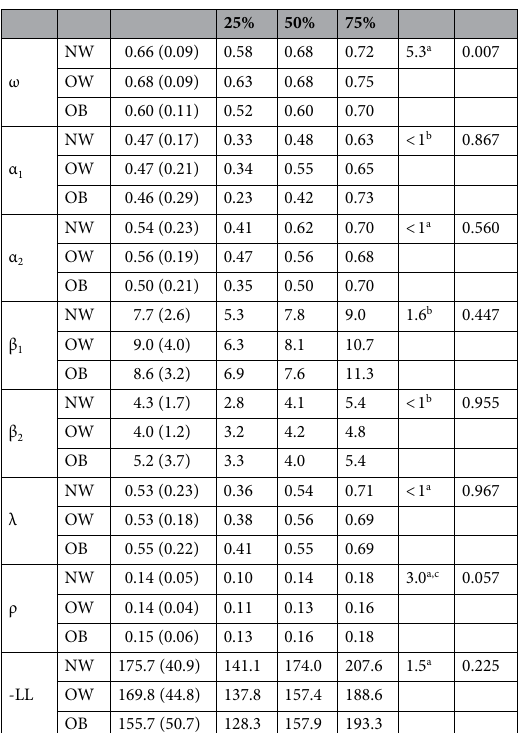
Table 2. Summary and group comparisons of all model parameters. NW normal-weight, OW overweight, OB obese. a F-test for normally distributed parameters (degrees of freedom: 2.87). b Independent-Samples Kruskal– Wallis Test of distributions for non-normally distributed parameters (degrees of freedom: 2). c One formal outlier was observed in the obese group and excluded from the analysis of this parameter (degrees of freedom: